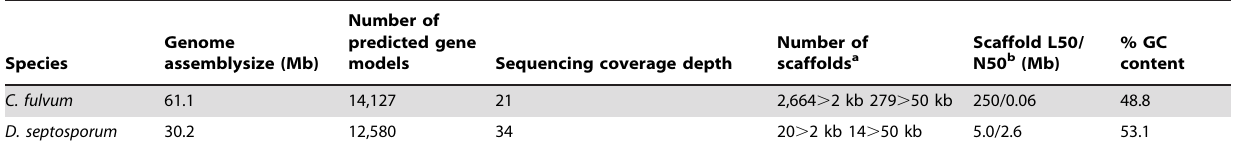
Table 1. C. fulvum and D. septosporum genome statistics.